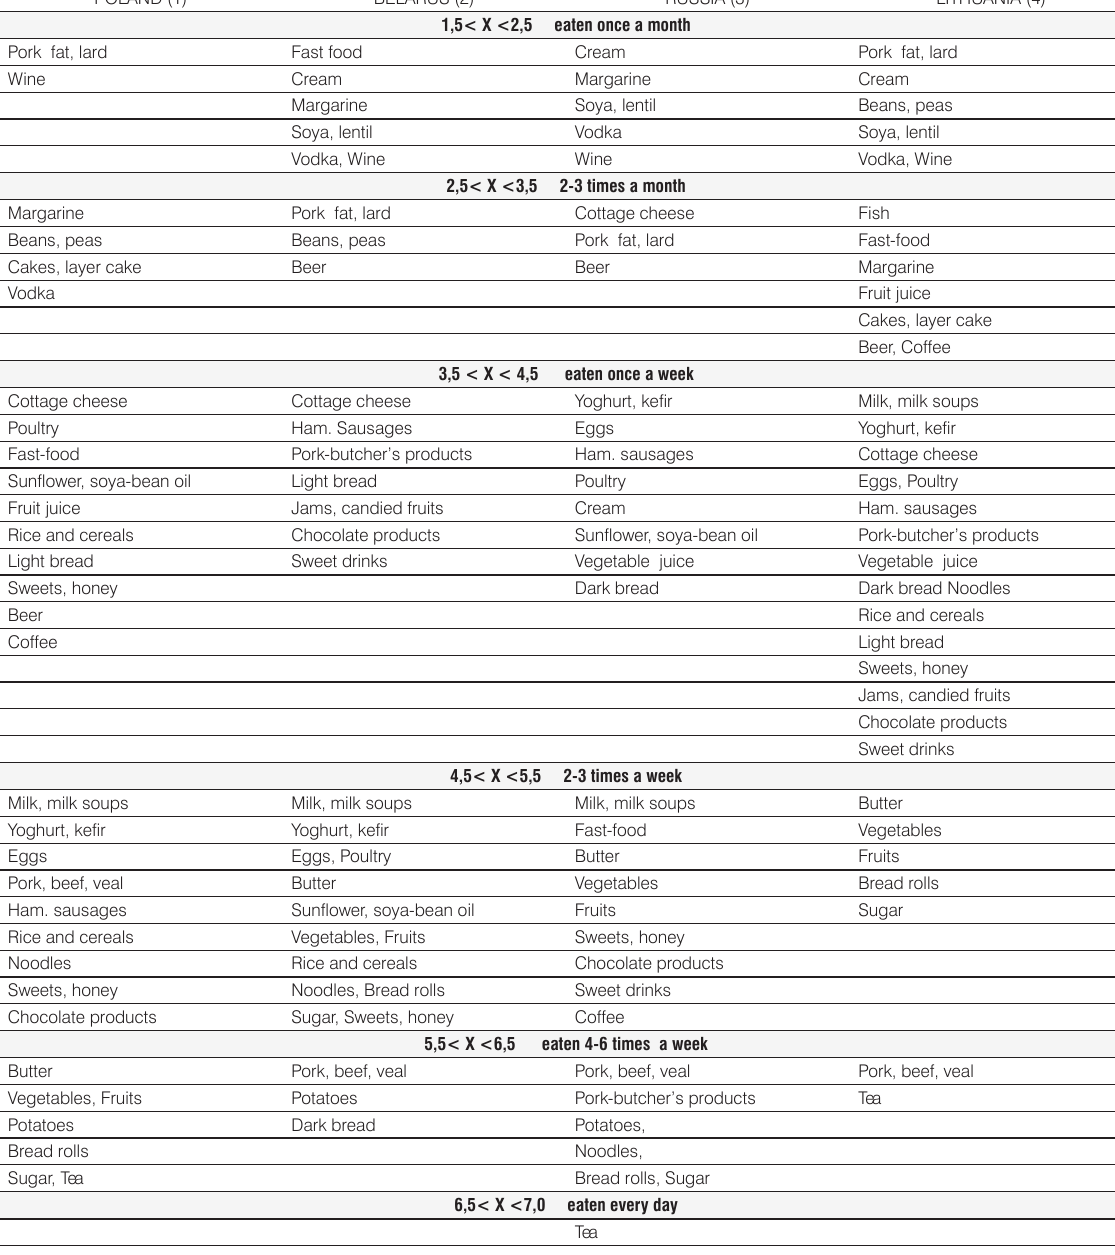
Table 7. Food products in the ranks of the consumption frequency in